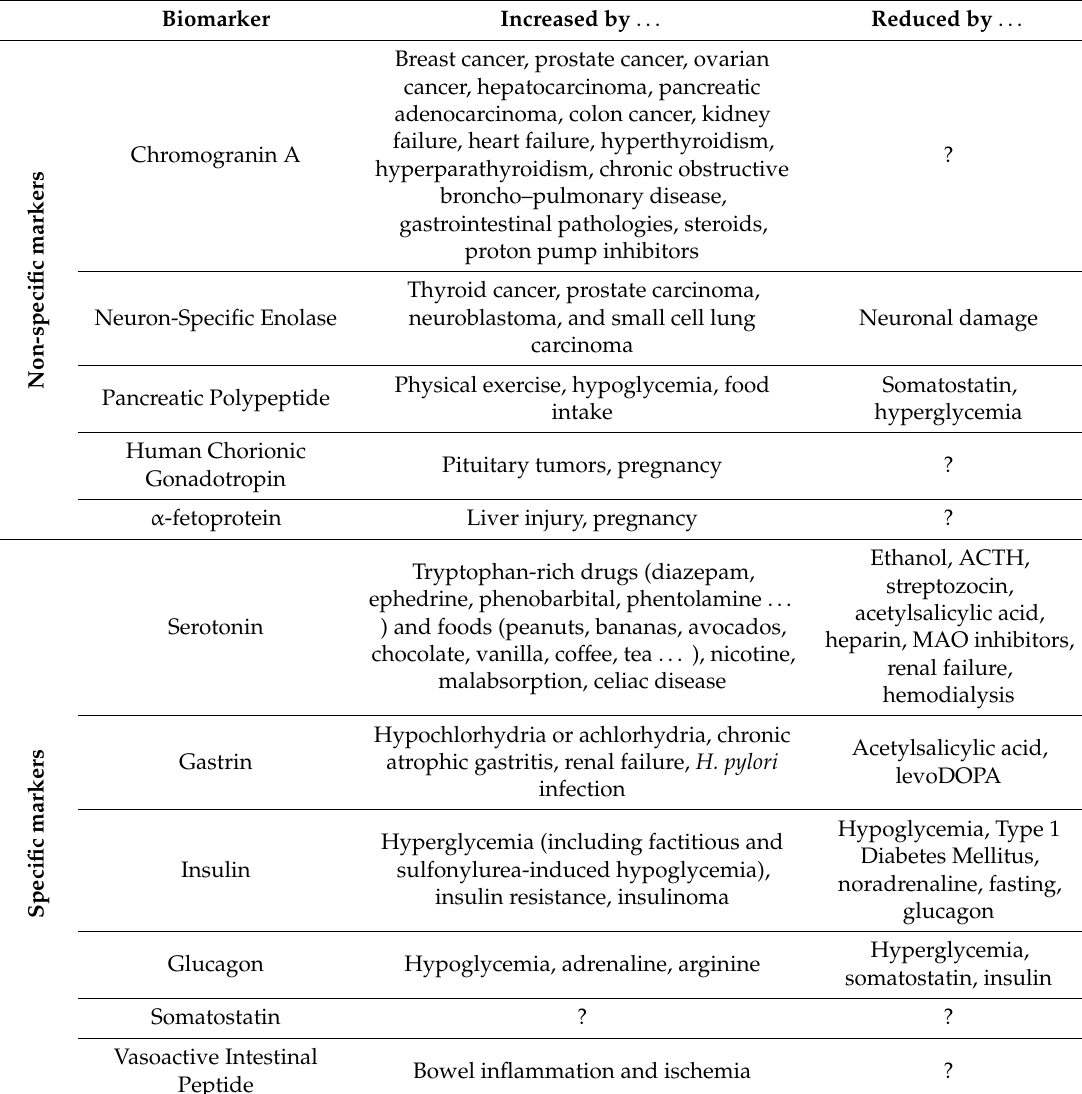
Table 1. Conditions, drugs, and foods interfering with serum biomarker assays. Biomarker Increased by ... Reduced by